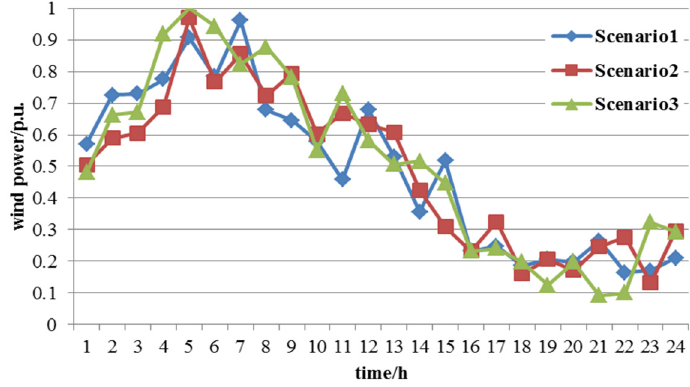
Figure 4. Peak-normalized wind power Figure 4. Peak ‐ normalized wind power scenarios. Figure 4. Peak ‐ normalized wind power scenarios. Table 1. Unit characteristics. Table 1. Unit characteristics.